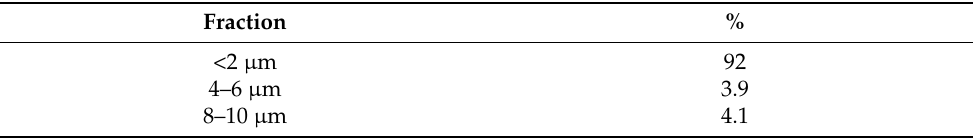
Table 5. Natural Na-montmorillonite particle size distribution